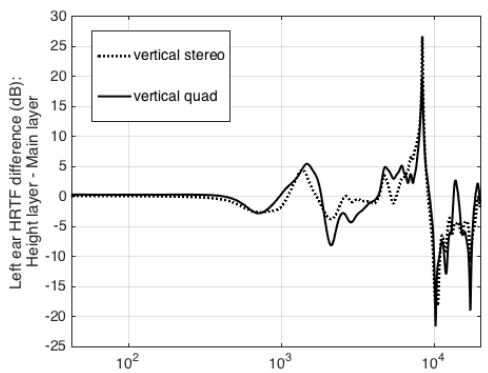
Figure 10. The differences in spectral energy between the main and height layer only conditions for both vertical stereophonic and vertical quadraphonic source presentation. both vertical stereophonic and vertical quadraphonic source